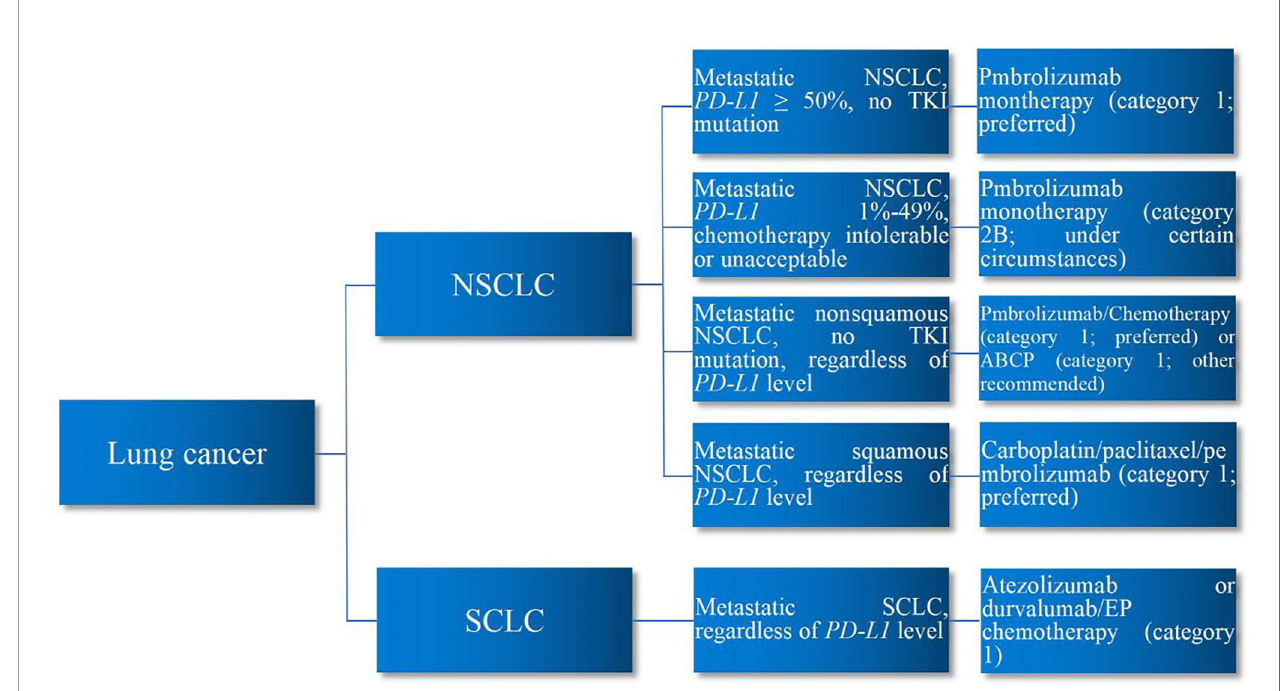
FIGURE 1 | First-Line ICI Immunotherapy for Lung Cancer. In the fi rst-line ICI immunotherapy of lung cancer, for metastatic NSCLC patients with PD-L1 ≥ 50% without TKI mutation, pembrolizumab monotherapy is preferred. For metastatic NSCLC patients with PD-L1 1% – 49% who are intolerable or unacceptable to chemotherapy, pembrolizumab monotherapy may be considered. Regardless of PD-L1 level, for metastatic non-squamous NSCLC patients without TKI mutation, pembrolizumab/chemotherapy is preferred or ABCP regimen may be considered. Regardless of PD-L1 level, for metastatic squamous NSCLC patients, carboplatin/ paclitaxel/pembrolizumab regimen is preferred. Regardless of PD-L1 level, for metastatic SCLC patients, atezolizumab or durvalumab/EP chemotherapy is preferred. ICIs, immune checkpoint inhibitors; NSCLC, non-small cell lung cancer; SCLC, small cell lung cancer; PD-L1 , programmed death-ligand 1; TKI , tyrosine kinase inhibitor; ABCP, atezolizumab/bevacizumab/carboplatin/paclitaxel; EP,